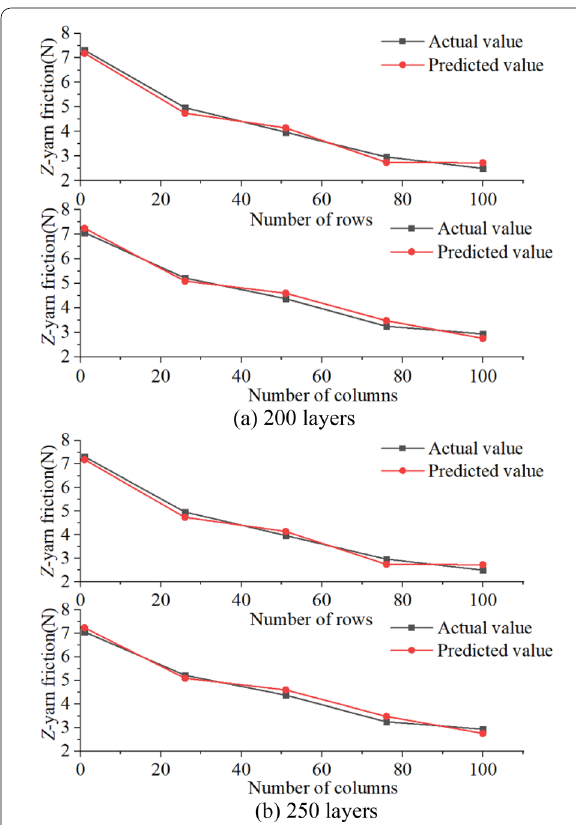
Figure 14 Fitting of preform with different layers and different positions Figure 15 Z-yarn tensile strength